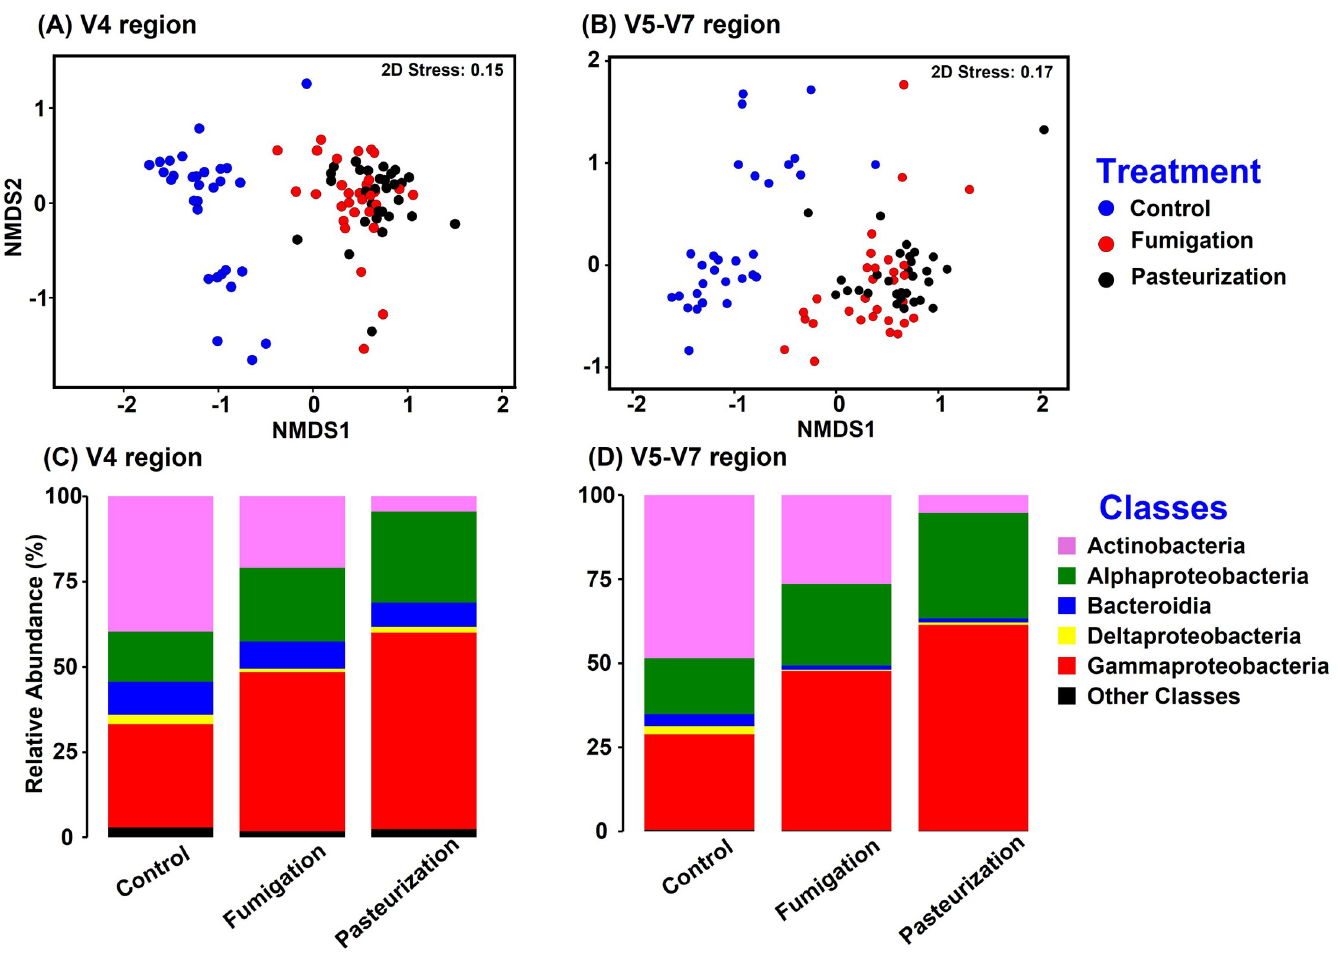
Fig 2. Response of bacterial communities in peach roots to preplant soil treatments among samples from the greenhouse bioassay. A and B , non-metric multidimensional scaling (NMDS) ordinations of the communities based on Bray-Curtis dissimilarities of ASV communities revealed by V4 (primers 515-806R) and V5-V7 (primers 799F-1193R), respectively; and C and D , combined class-level summary of ASV relative abundances based on V4 and V5-V7 amplicons, respectively. For NMDS, Bray-Curtis dissimilarity matrices were generated after cumulative sum scaling (CSS) normalization and square-root-transformation. The class level abundances were calculated after